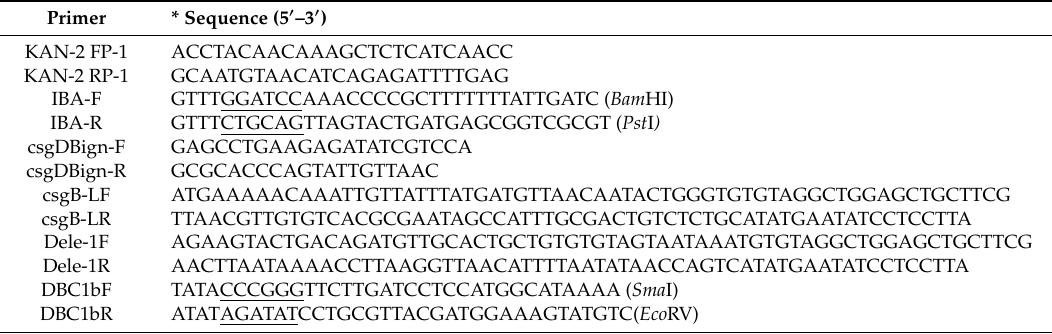
Table 2. Oligonucleotide